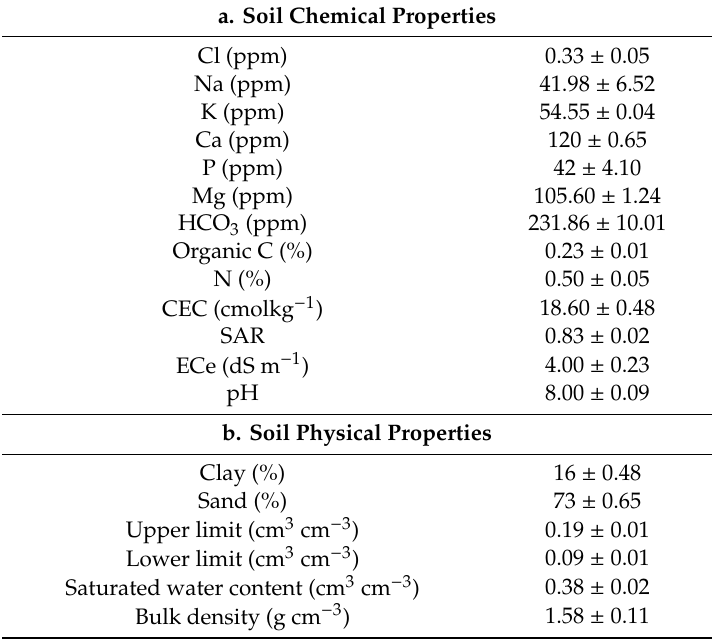
Table 1. Soil chemical and physical properties in the Jordan Valley experiment at the field initial conditions before planting. CEC is the cation exchange capacity of the soil and SAR is the sodium adsorption ratio. The values are reported with their standard